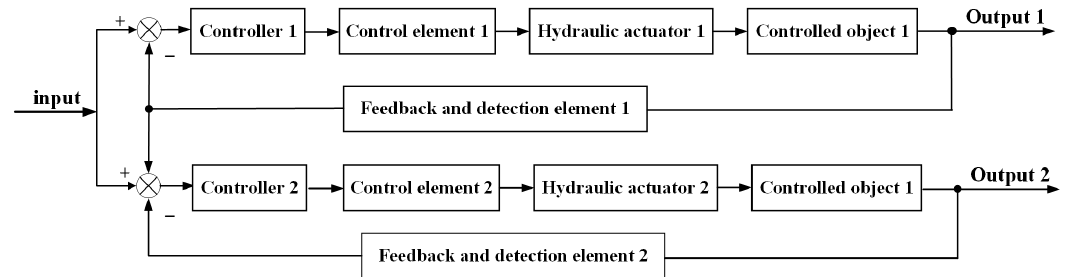
Figure 3. Master–slave control block diagram of hydraulic synchronous control system.